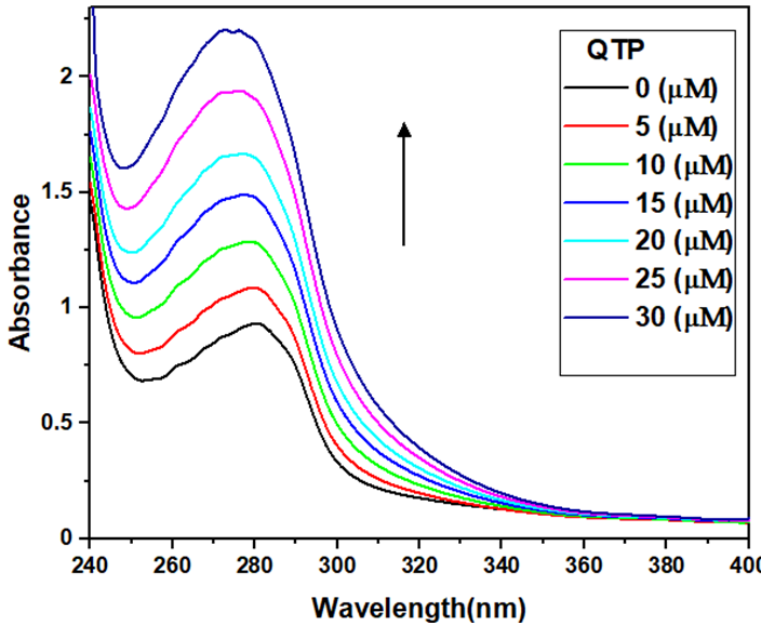
Figure 2. UV absorption spectra of HSA (5 µ M) in the absence and presence of increasing concentrations of QTP (5–30 µ M) in the wavelength range 240–410 nm.